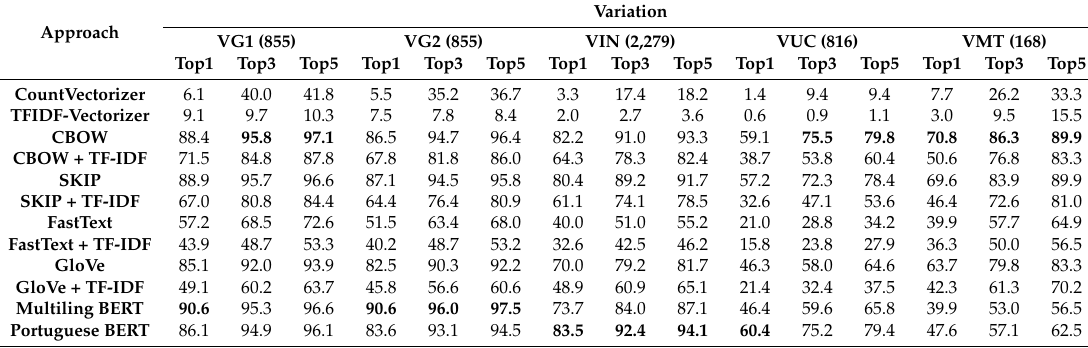
Table 6. Proportion of variations of different types correctly matched with original FAQs (Top1), in Top-3 and in Top-5 most similar, using different Word Vector approaches.